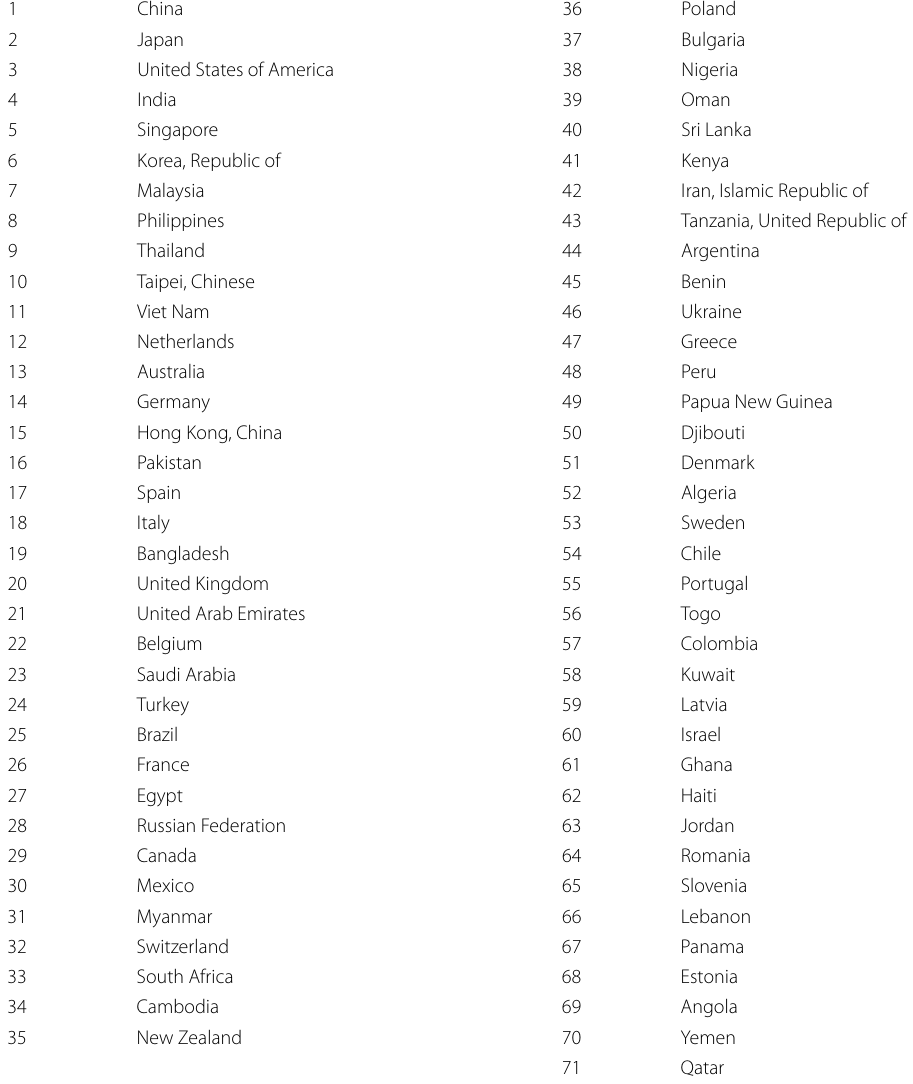
Table 10 List of Indonesia trading partners included in the